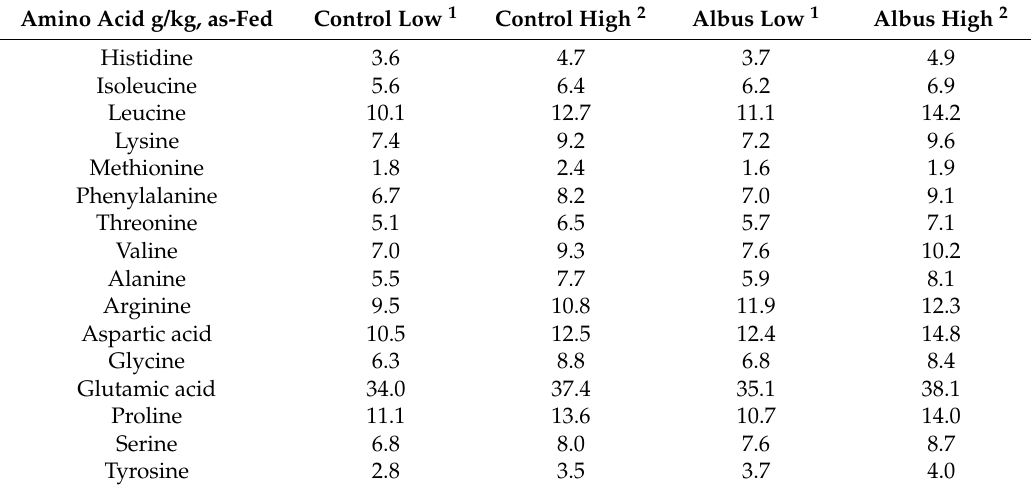
Table 2. Quantitative amino acid analysis of the diets.